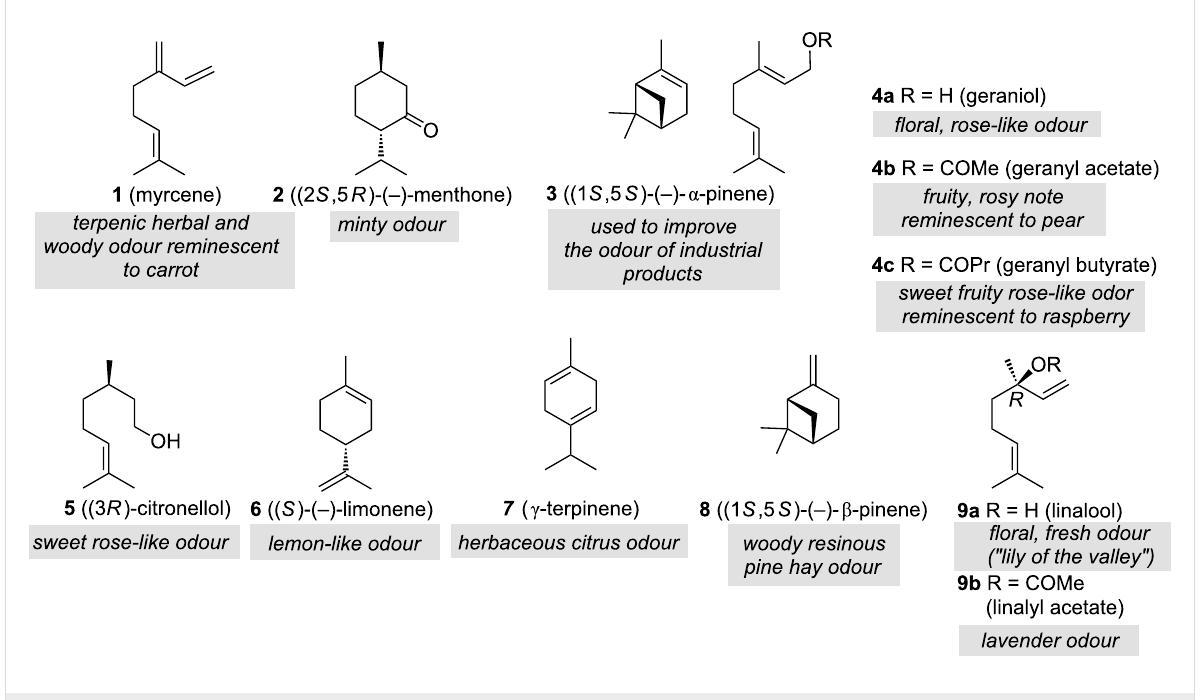
Figure 1: Terpene constituents 1 – 9 found in geranium and bergamot oils and specified odours of individual components. Perfumes are composed of compounds that are perceived immediately (top notes), that form the principal bouquet (heart notes) and compounds that are mainly perceived in the dry-out (bottom notes) [6]. Classification of 1. top notes: a) citrus, b) aldehydic, c) fruity, d) green and e) herbaceous/herbal, 2. heart notes: a) floral light, b) floral green, c) floral fresh, d), floral fruity, e) floral heavy and f) floral woody and 3. bottom notes: a) aromatic, b) balsamic, c) moss/leather/ animalic, d) musk, e) amber and f)